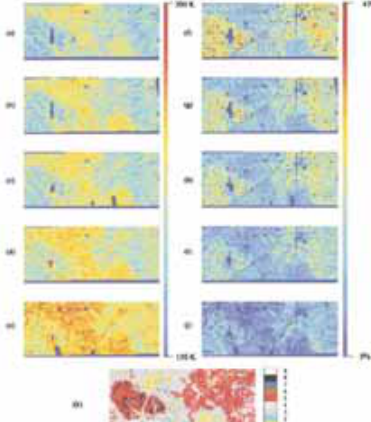
Fig. 7: Remotely sensed brightness temperature in 0 K [(a) June 10; (b) June 12; (c) June 14; (d) June 16; (e) June 18] and derived